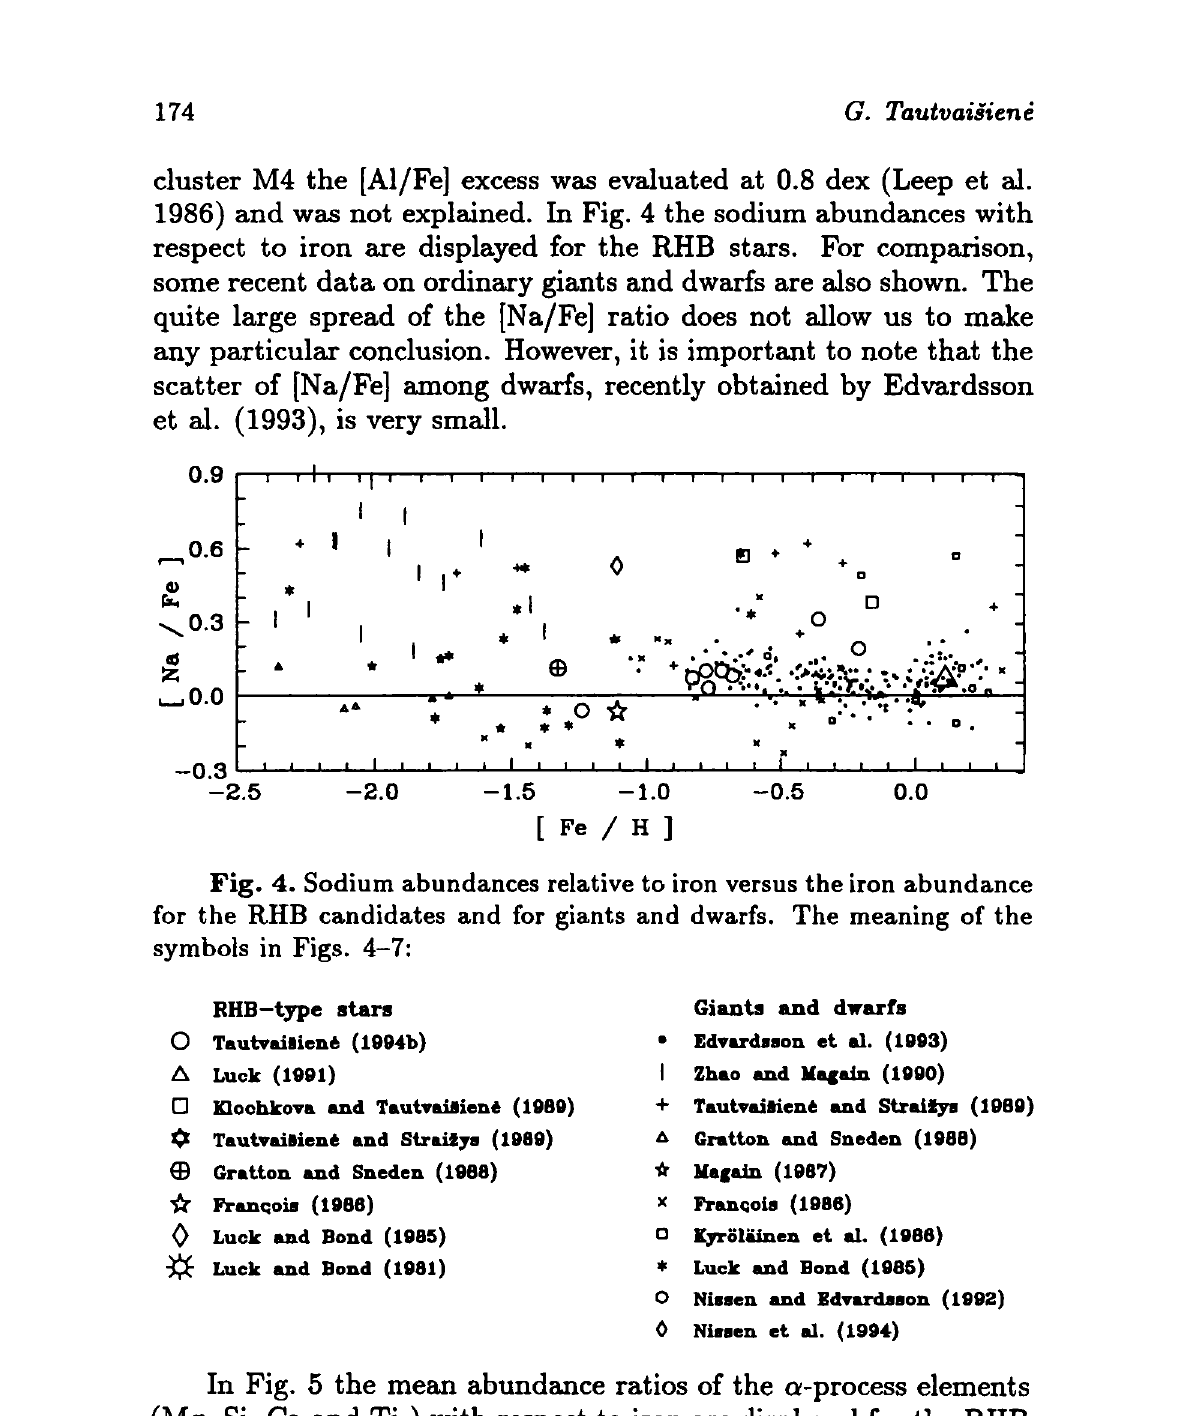
Fig. 4. Sodium abundances relative to iron versus the iron abundance for the RHB candidates and for giants and dwarfs. The meaning of the symbols in Figs.